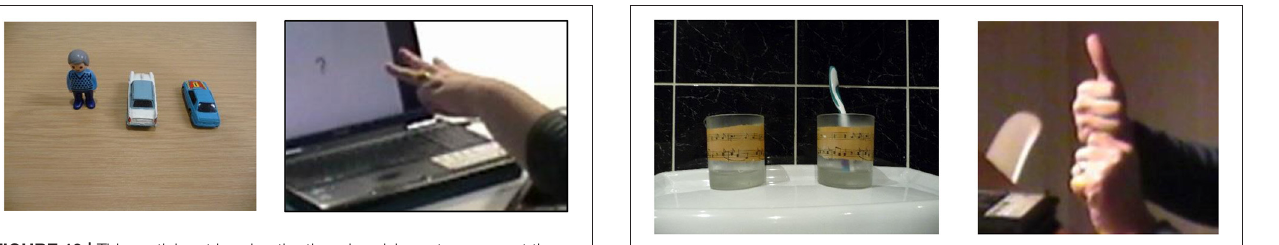
FIGURE 12 | This participant is using two fists to represent the cups, with an extended thumb to represent the